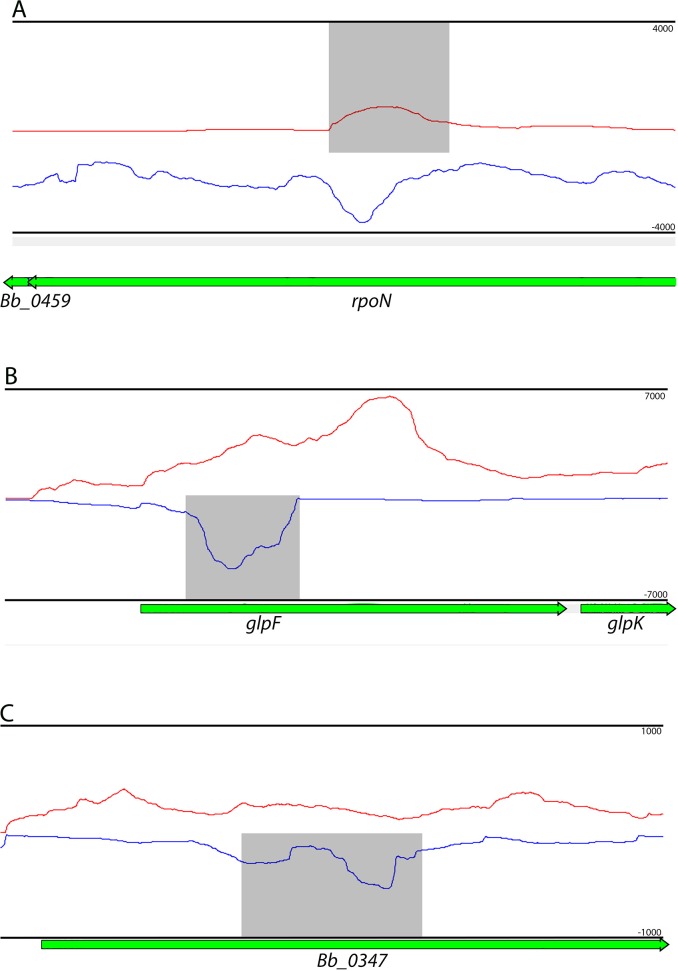
Examples of putative antisense noncoding RNAs.Read coverage histograms of previously antisense ncRNAs that overlap; rpoN, glpF, and ORF Bb_0347. Read Red lines indicate transcript abundance from the + strand (left to right) and blue indicate transcript abundance from the–strand (right to left), and are shown above (+) and below (-) the central axis. Genes are noted below coverage plots and directionality is given by arrows at the ends of genes. Relative orientation of genes on the X axis is consistent with RefSeq annotations. Coverage per base is given on the Y axis to the left of the plot. ncRNAs are highlighted by grey boxes determined by their predicted start and end sites determined in S8 Table. Identified Rho-independent terminators are indicated by red boxes, and directionality is shown by arrows at their ends.